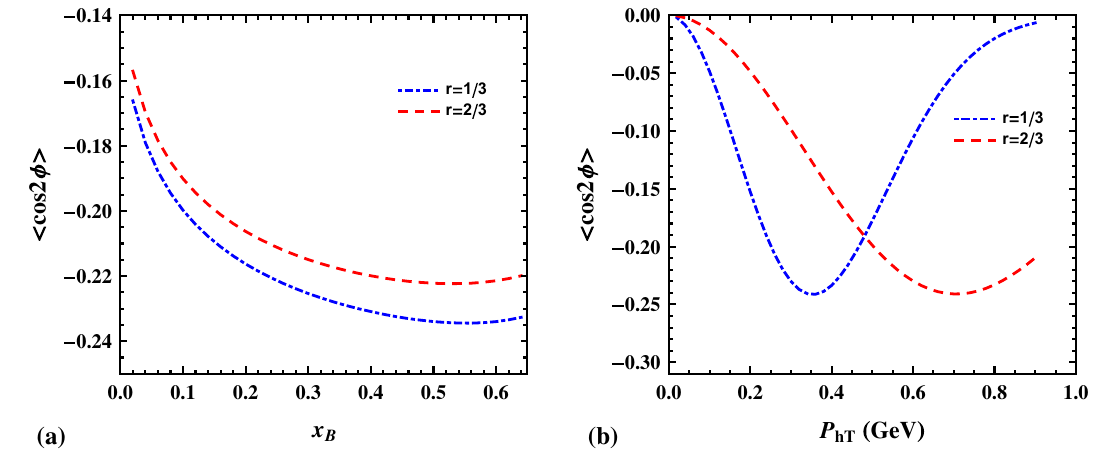
√ s = 17 . 2 GeV (COMPASS).